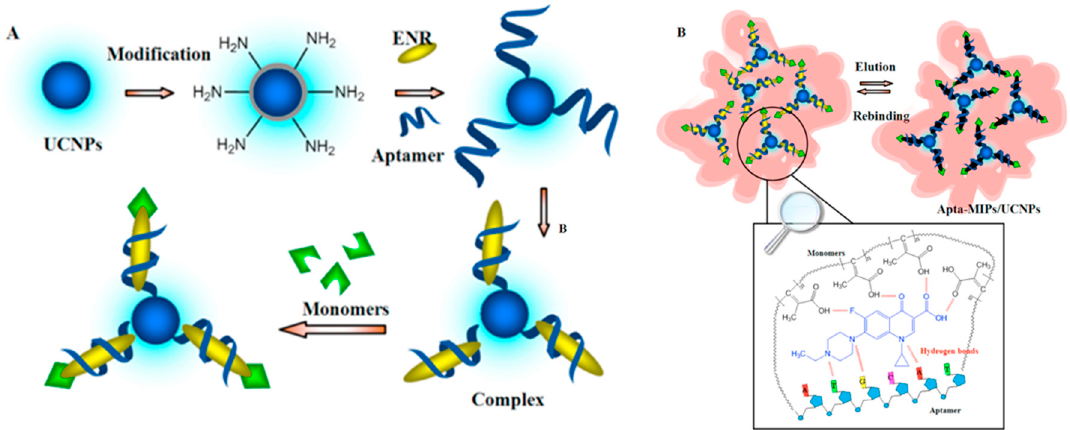
Figure 8. Schematic representation of the preparation ( A ) and recognition ( B ) processes for the up-conversion nanoparticles (UCNPs)@Apta-MIP selective to enrofloxacin. Reproduced from [116] with permission of